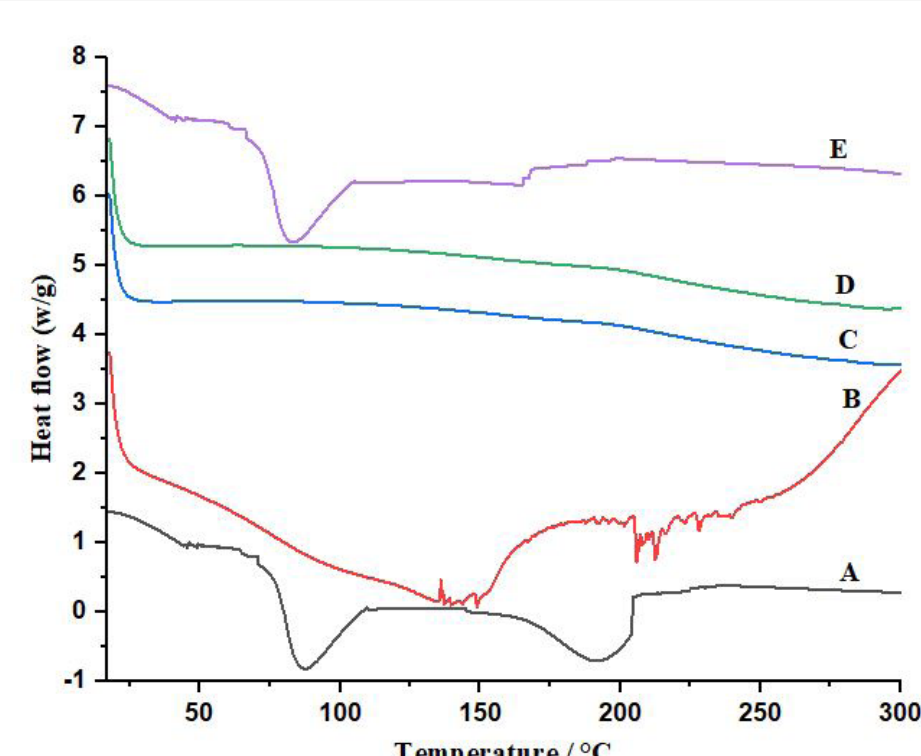
FIGURE 4 - DSC thermograms of Metoclopramide (A), Eudragit L100 (B), Polyvinylpyrrolidone K30 (C), Methylcellulose (D) and Z4